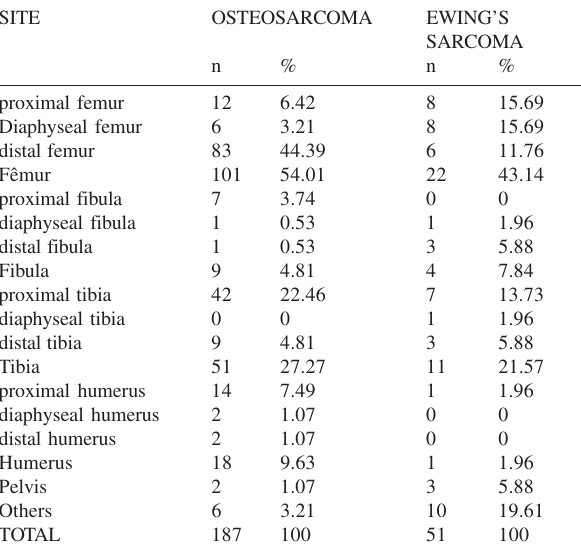
Table 3 - Absolute and relative frequency distribution (%) of sites affected by Osteosarcoma or Ewing’s Sarcoma, by joint involved, and intergroup comparison using a two-tailed chi-square test ( α =0.05)